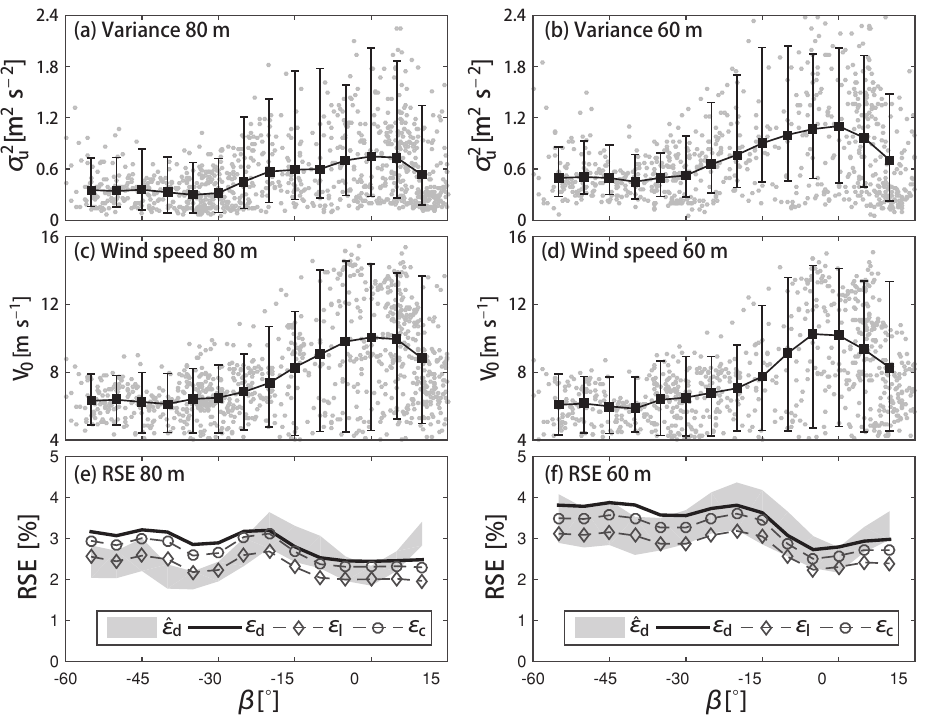
Figure 6. Variation of the standard error (RSE) with the relative direction ( β ) at Site A at 80m height in (a, c, e) and 60m height in (b, d, f) . The RSE is given in (e, f) for the 95% confidence interval of the observed difference between the cup and lidar measurements ( ˆ ε d ), the predicted difference between the cup and lidar measurements ( ε d ), the predicted cup error ( ε c ), and the predicted lidar error ( ε l ). The input for the RSE predictions include the mean wind speeds ( V 0 ) shown in (c, d) and the mean wind speed variance ( σ 2 u ) shown in (a, b) for 80m height and 60m height,